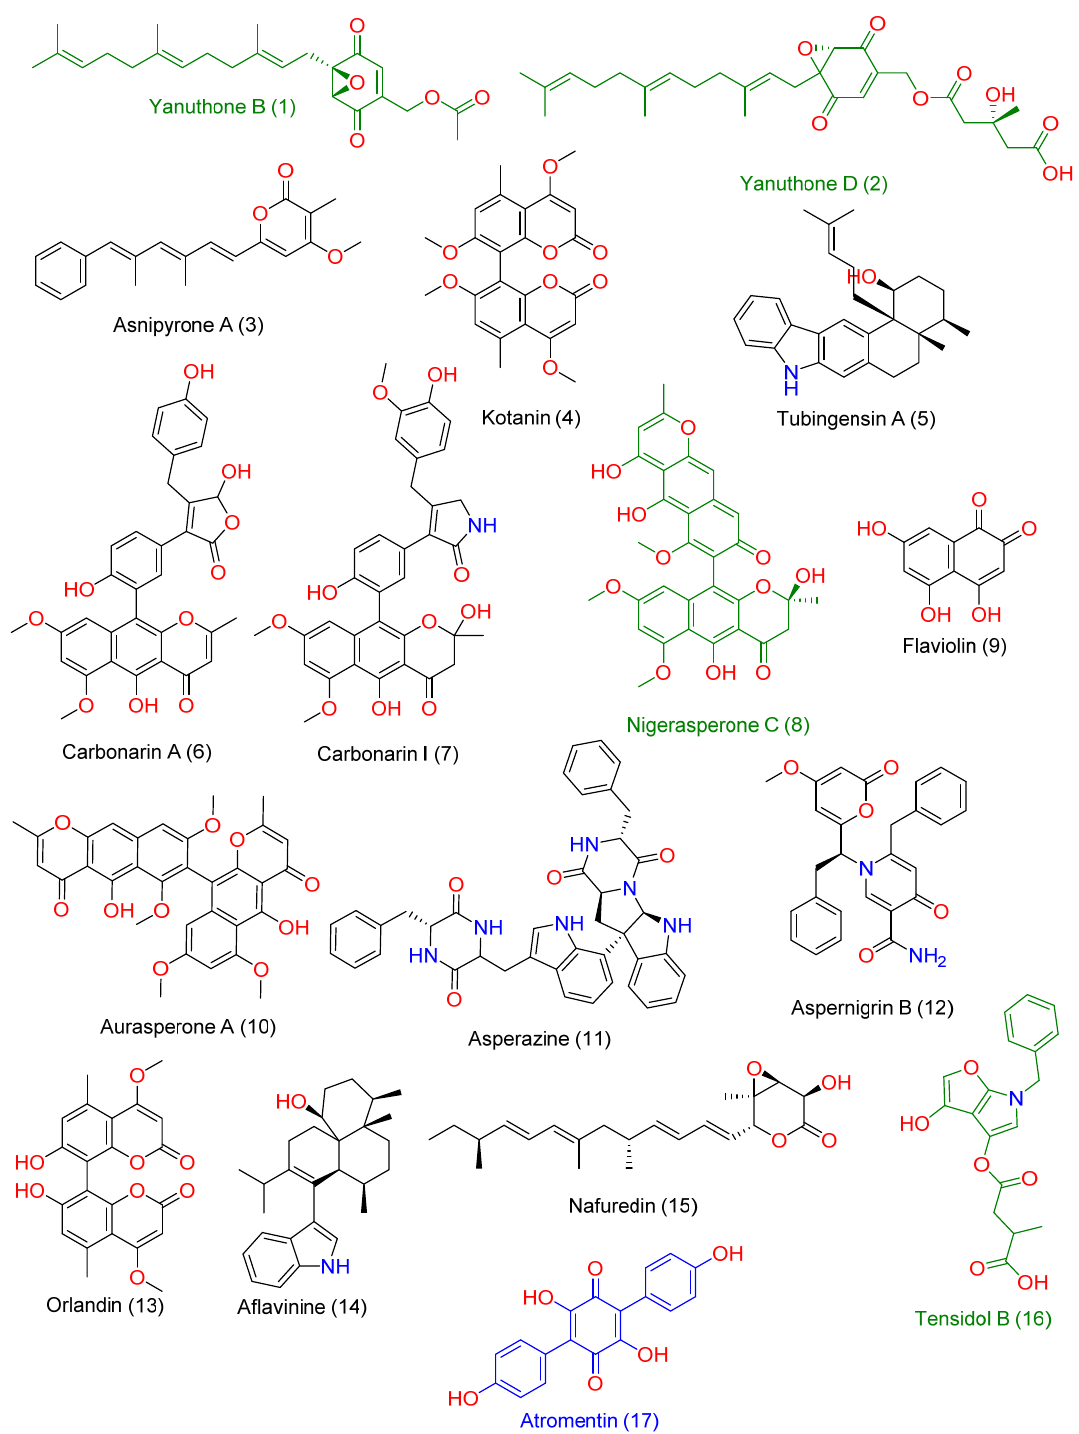
Figure 5. Chemical structures of the compounds 1 – 17 were putatively dereplicated in Aspergillus sp. AP5-derived extract. Green-colored compounds were previously reported to have antifungal activ- ity, while blue-colored compound (compound 17 ) has been reported to have antibacterial